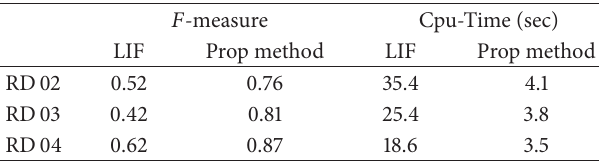
Table 1: Evaluation of segmentation accuracy and computation time.